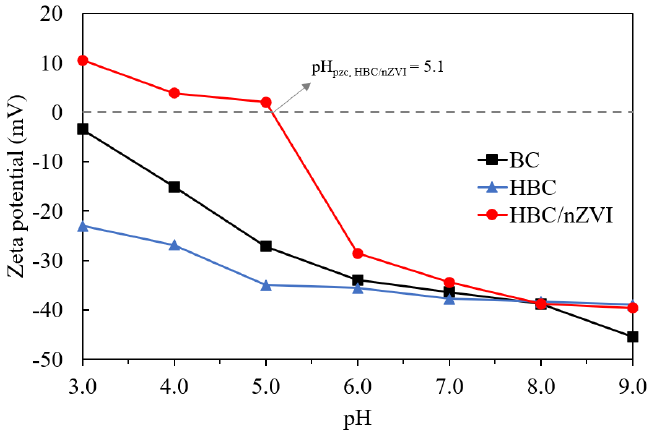
Figure 4. Zeta potential data of BC, HBC, and HBC/nZVI as a function of pH (measured in 10 mM NaCl electrolyte solution at 25 °C).